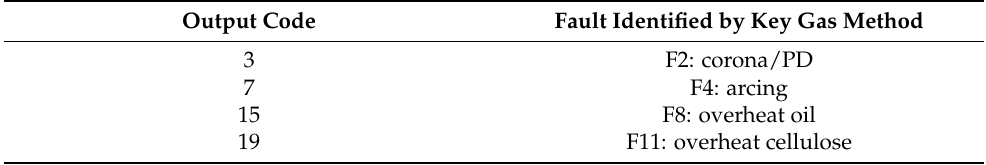
Table 6. Fuzzy output codes and faults using the key gas method.